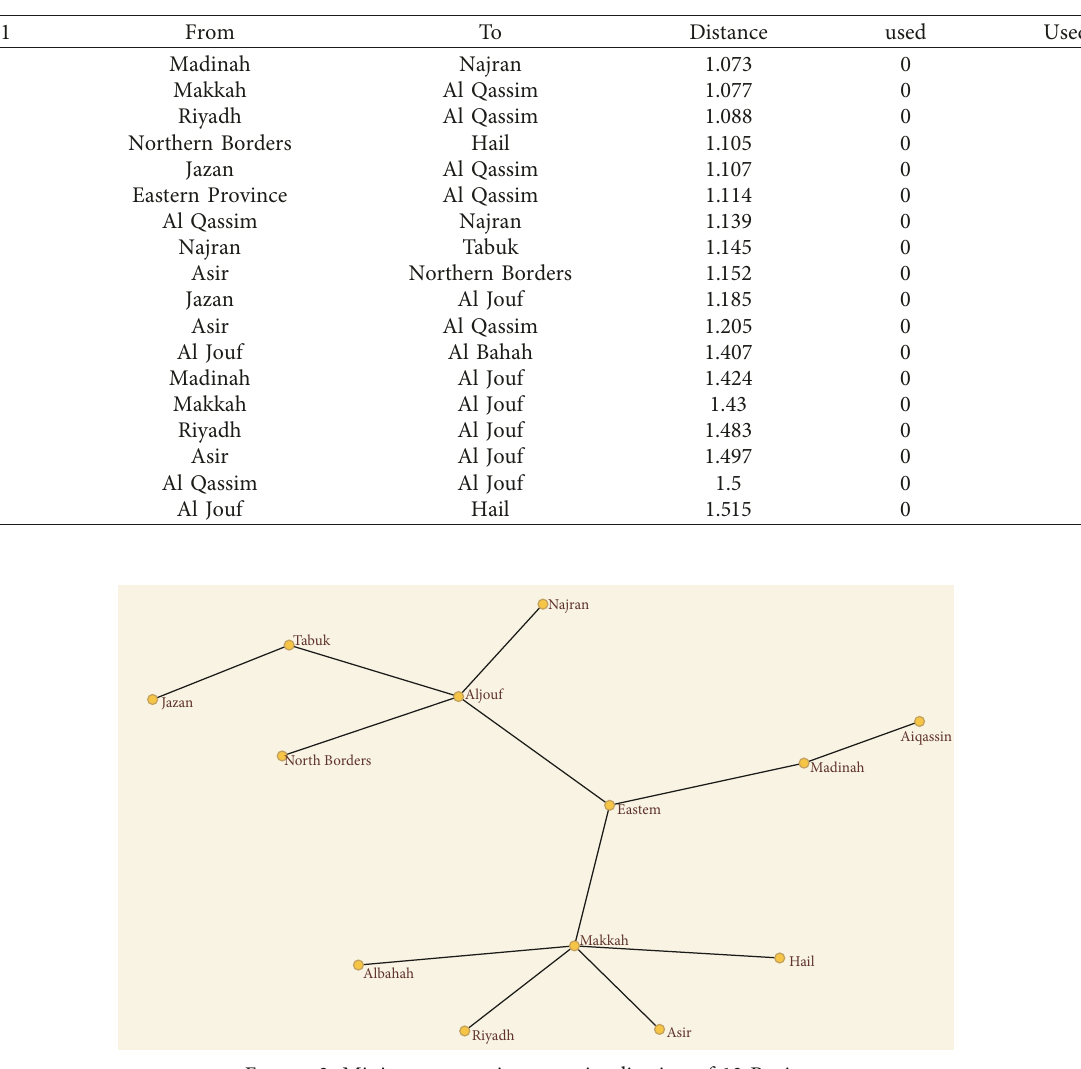
Figure 2: Minimum spanning tree visualization of 13